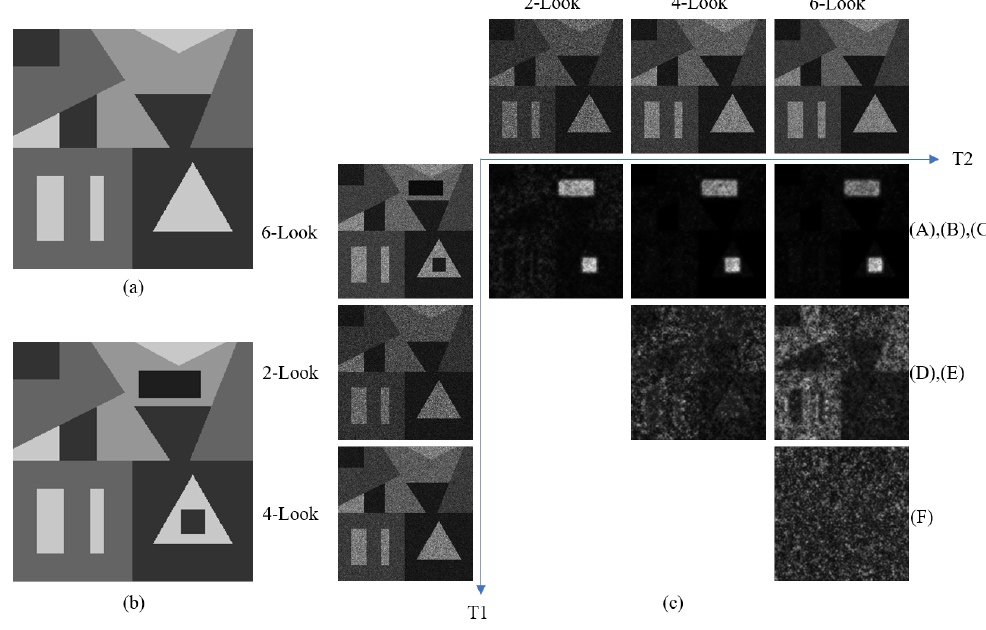
Figure 4. Noise sensitivity test on the simulated SAR image. ( a ) T1 image. ( b ) T2 image. ( c ) Change difference intensity map matrix. We added 2-look, 4-look, and 6-look speckle noise to T1 image. We added 6-look speckle noise to T2